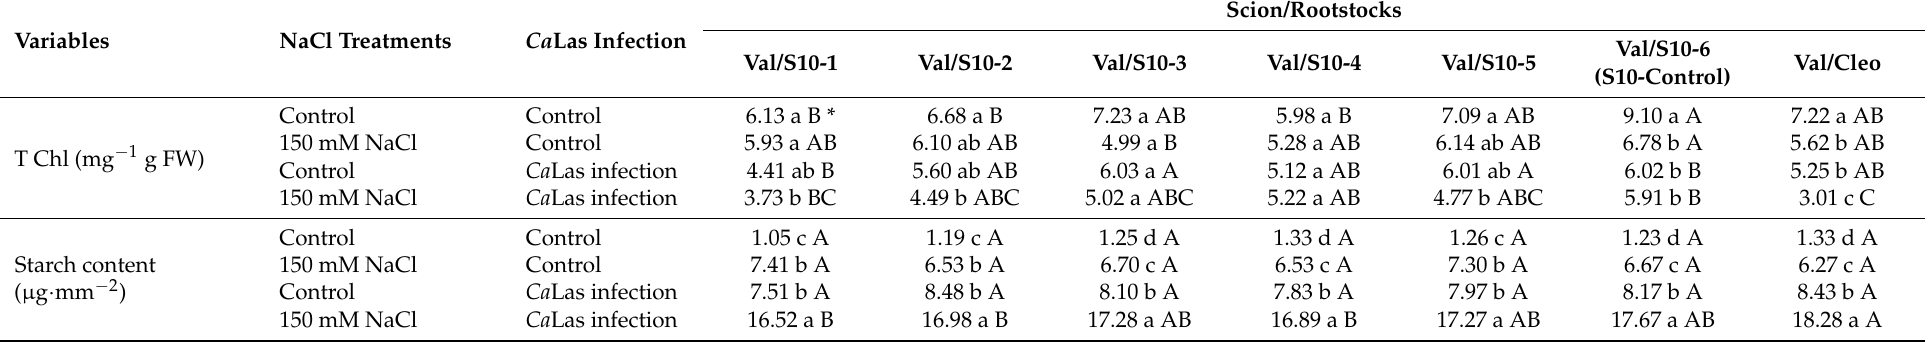
Table 2. NaCl treatment and Ca Las infection on total chlorophyll and starch content of ‘Valencia’ sweet orange scions grafted onto S10-derived rootstocks and Cleopatra mandarin (control).